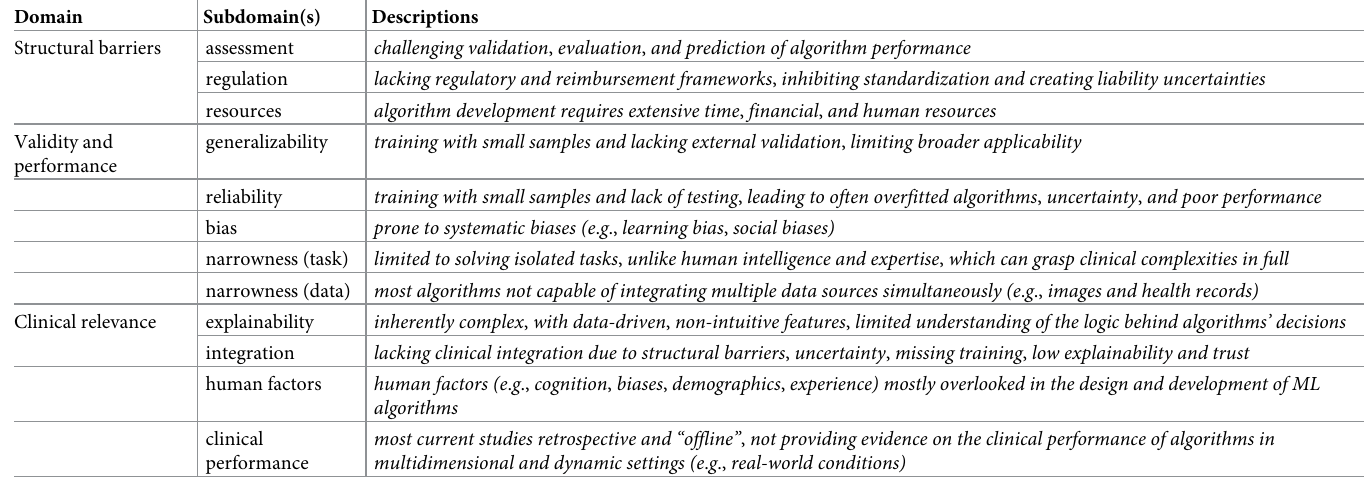
Table 4. General machine learning challenges, as reported in the